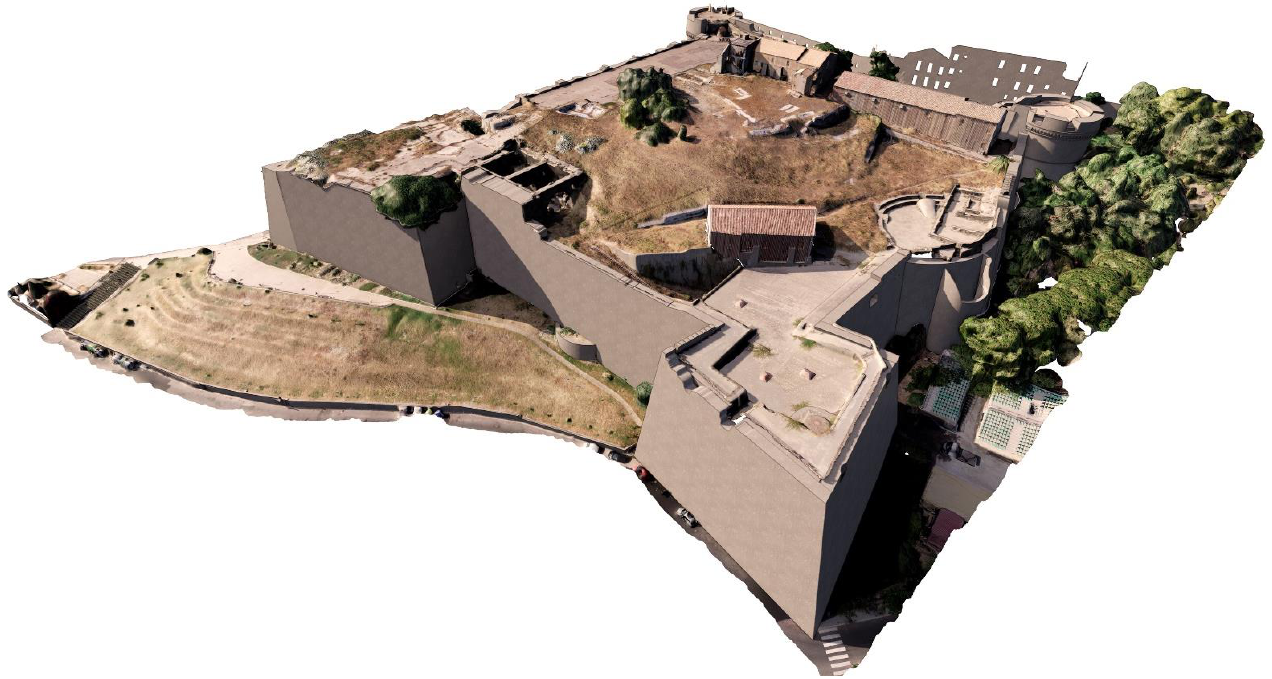
Figure 14. View of the rendered federated models.